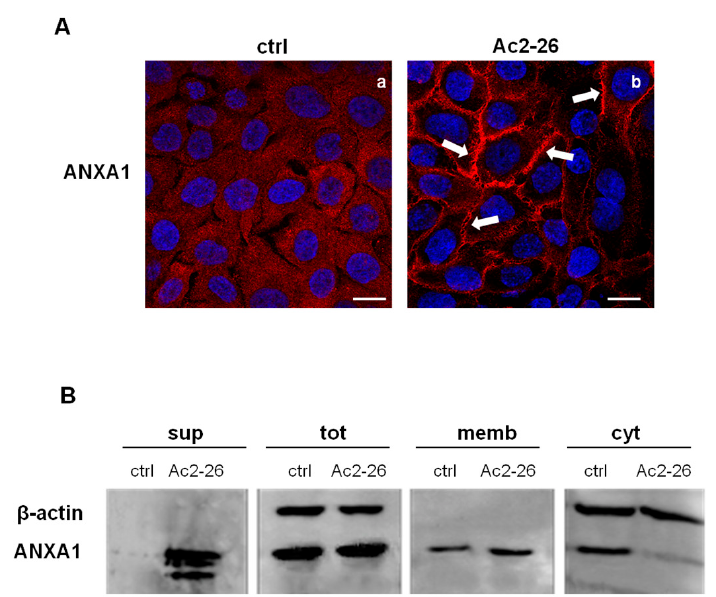
Figure 3. ( A ) Immunofluorescence analysis to detect ANXA1 in keratinocytes not treated (a) and treated with Ac2-26 1 µ M (panel b). Magnification 63 × 1.4 NA. Bar = 20 µ m. ( B ) Extracellular, whole, membrane, and cytosol expression of ANXA1 in HaCaT cells treated or not with Ac2-26 1 µ M was